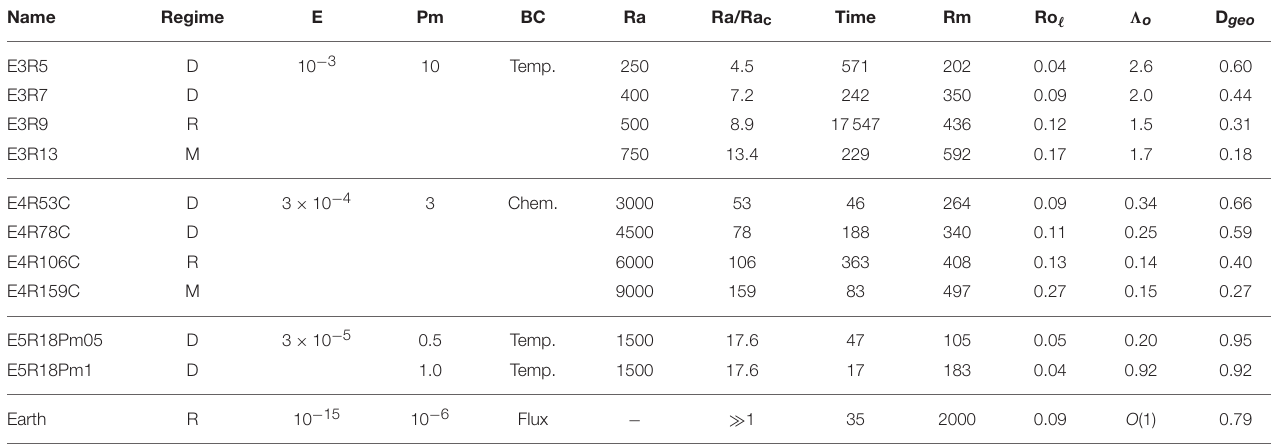
TABLE 1 | List of input parameters and time averaged properties for the explored dynamo models and for Earth. Name